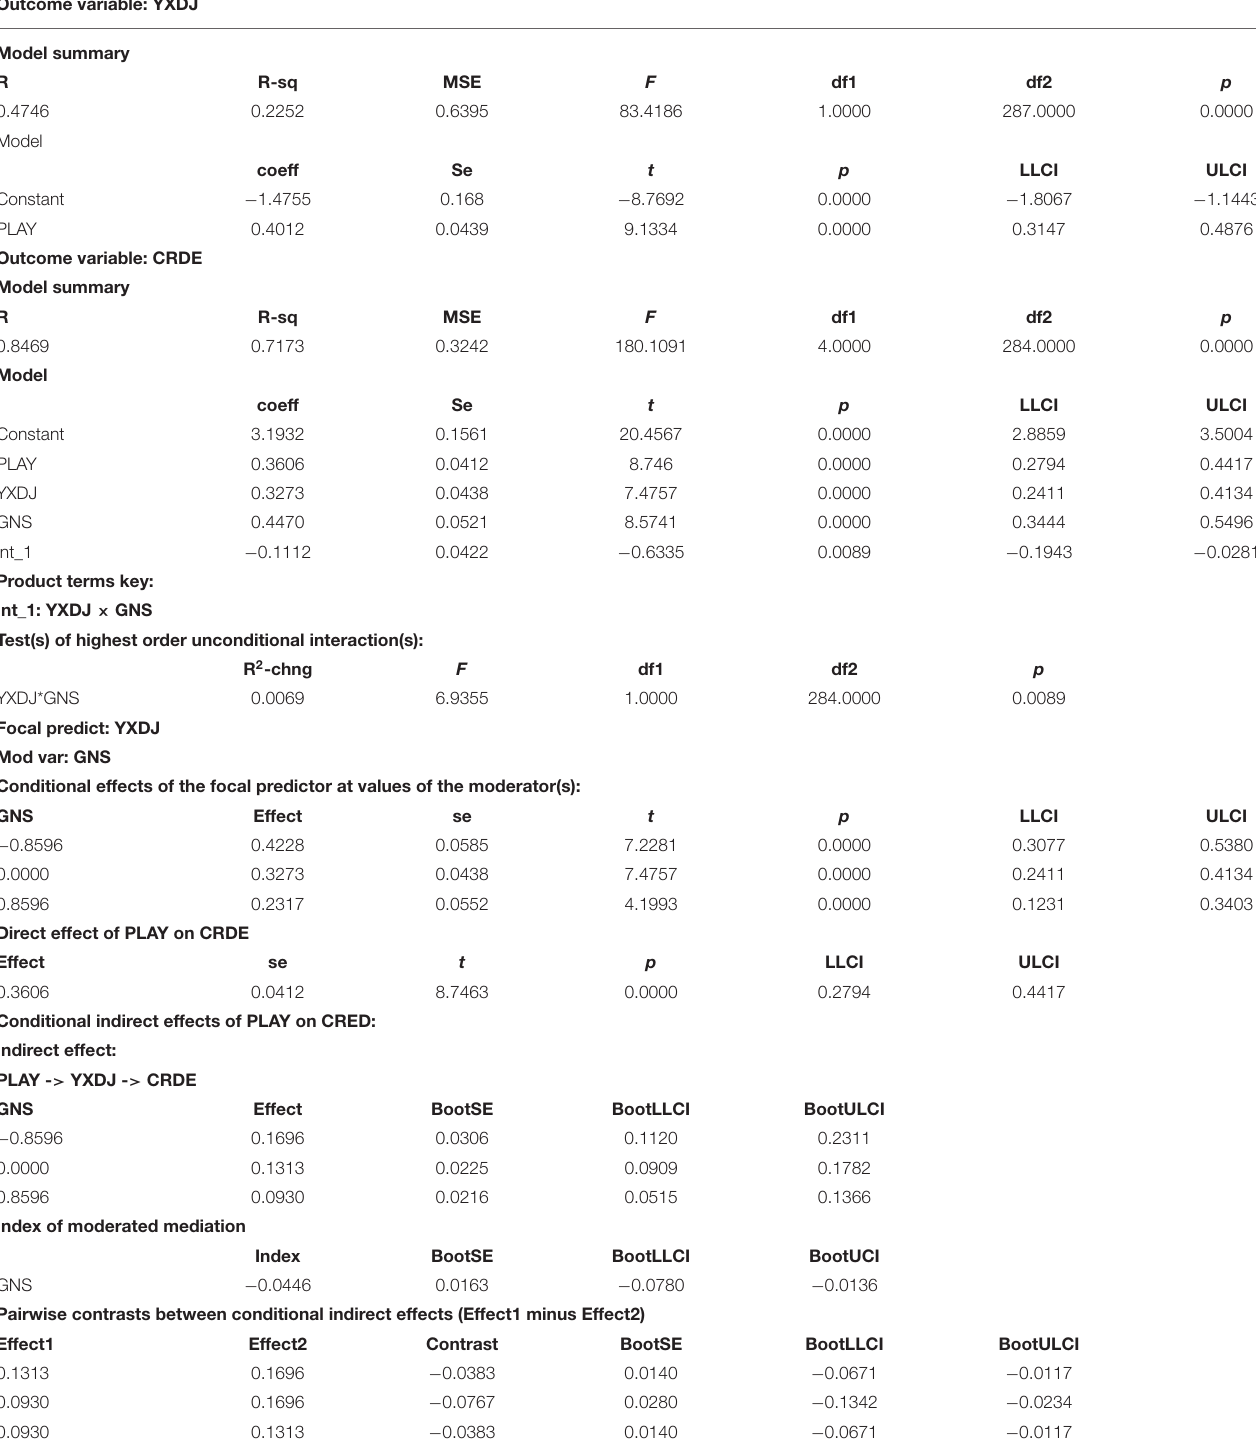
TABLE 16 | The moderation mediating effect test results. Outcome variable: